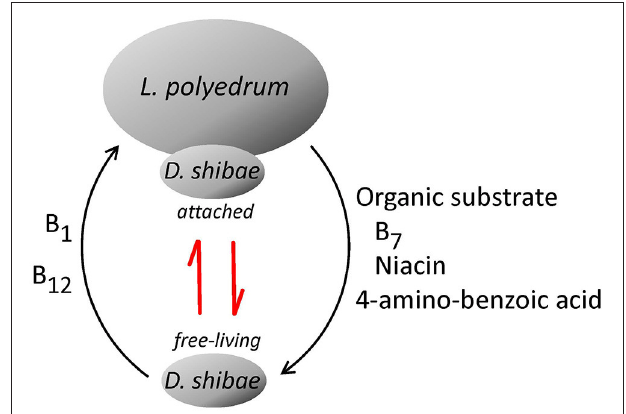
FIGURE 4 | Proposed mutualism of L. polyedrum and D. shibae . Depending on the degree of B 1 and B 12 limitation L. polyedrum liberates growth promoters for D. shibae , for example, B 7 , niacin and 4-amino-benzoic acid. D. shibae responds with an increased tendency to attach to L. polyedrum cells and to produce B 1 and B 12 . The red arrows indicate the kinetic between free-living and attached lifestyle of D. shibae based on the dissolved pool of B 1 and B 12